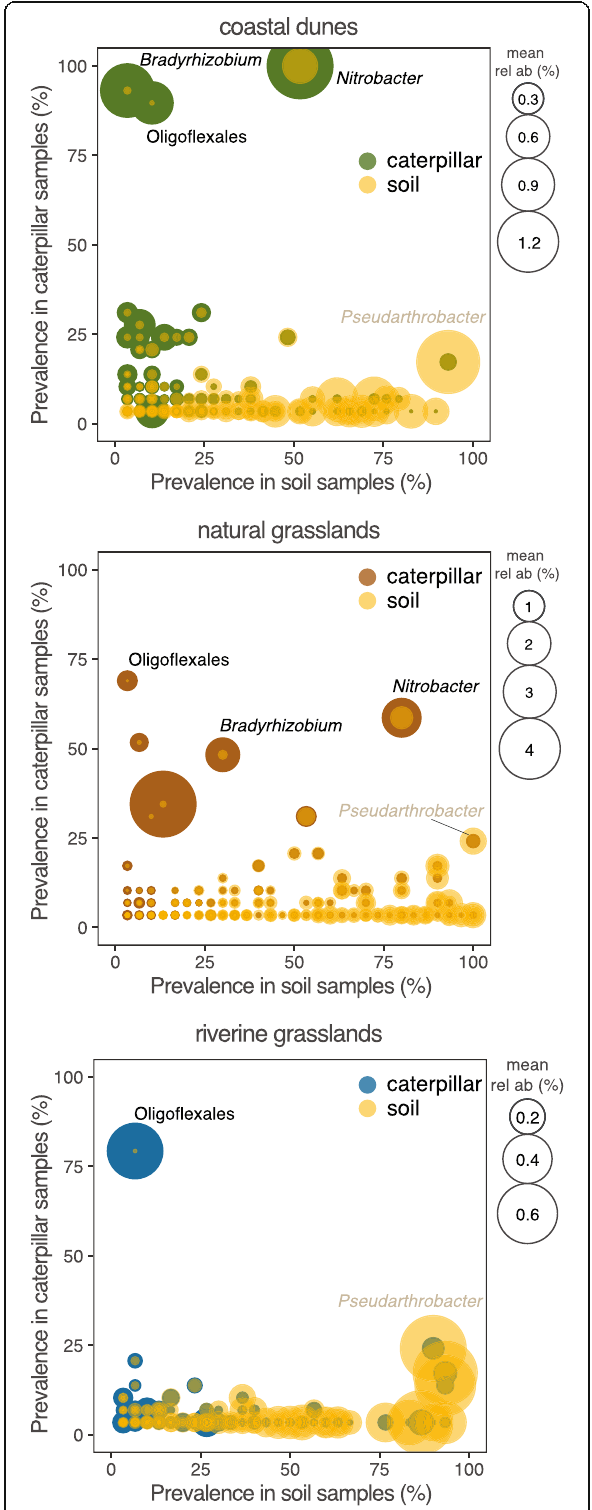
Fig. 5 Shared microbiomes between caterpillar and soil samples in the three habitats. There were 221, 390 and 176 ASVs in common between caterpillar and soil samples in coastal dunes, natural grasslands and riverine grasslands, respectively. Most prevalent taxa in caterpillars are depicted. The same ASV identified as Oligoflexales occurred in the three habitats. ASVs identified as Nitrobacter and coastal dunes and natural grasslands, and only in caterpillar samples in riverine grasslands. Pseudarthrobacter was the most prevalent